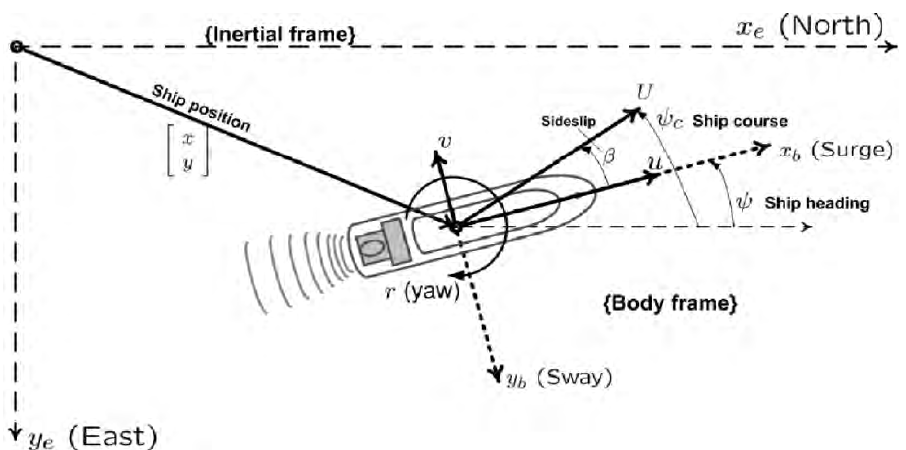
Figure 1. Figure showing the inertial earth-fixed frame and the body-fixed frame for a ship with the earth-fixed position ( x , y ), the heading t , and the corresponding body-fixed velocities ( u , v ) and rotation rate r